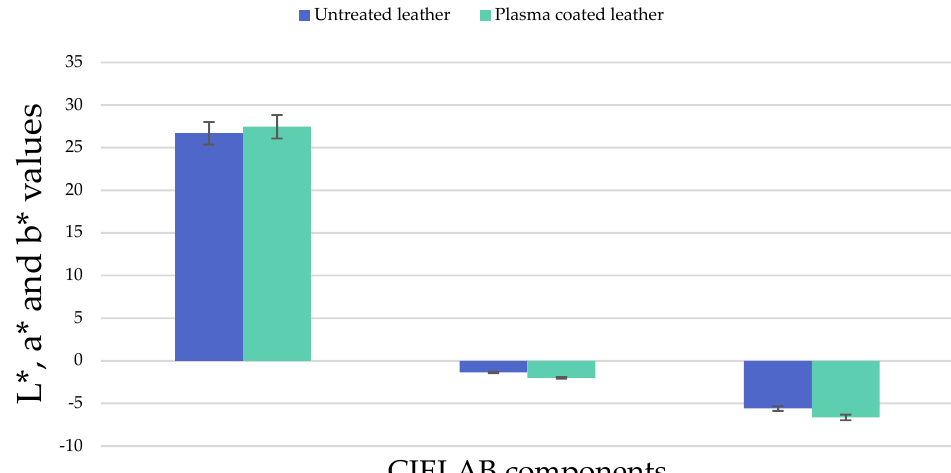
Figure 6. L*, a* and b* values for both untreated and plasma treated leather.